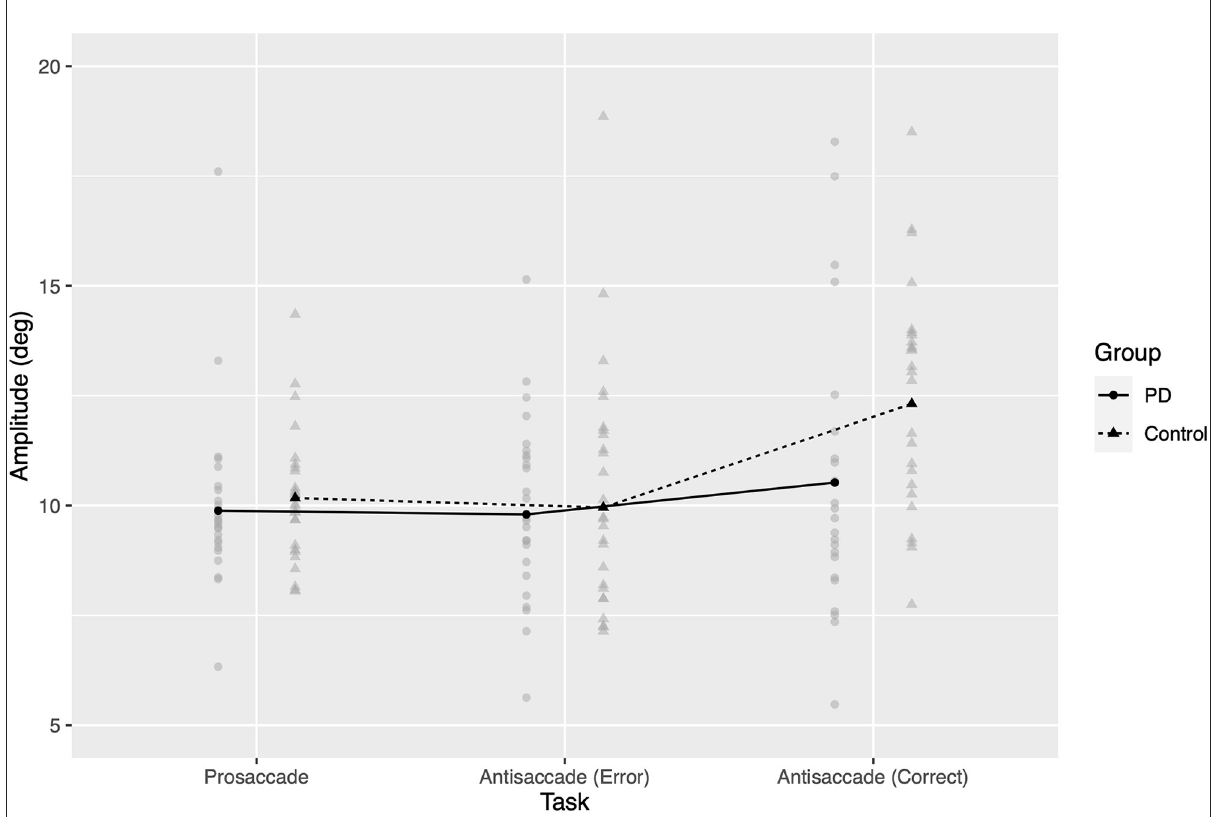
FIGURE4 Amplitude of saccadic response, back-transformed from model of square root of amplitude. Gray points represent amplitude for one participant in a given task. Black points and lines represent estimated marginal group means.